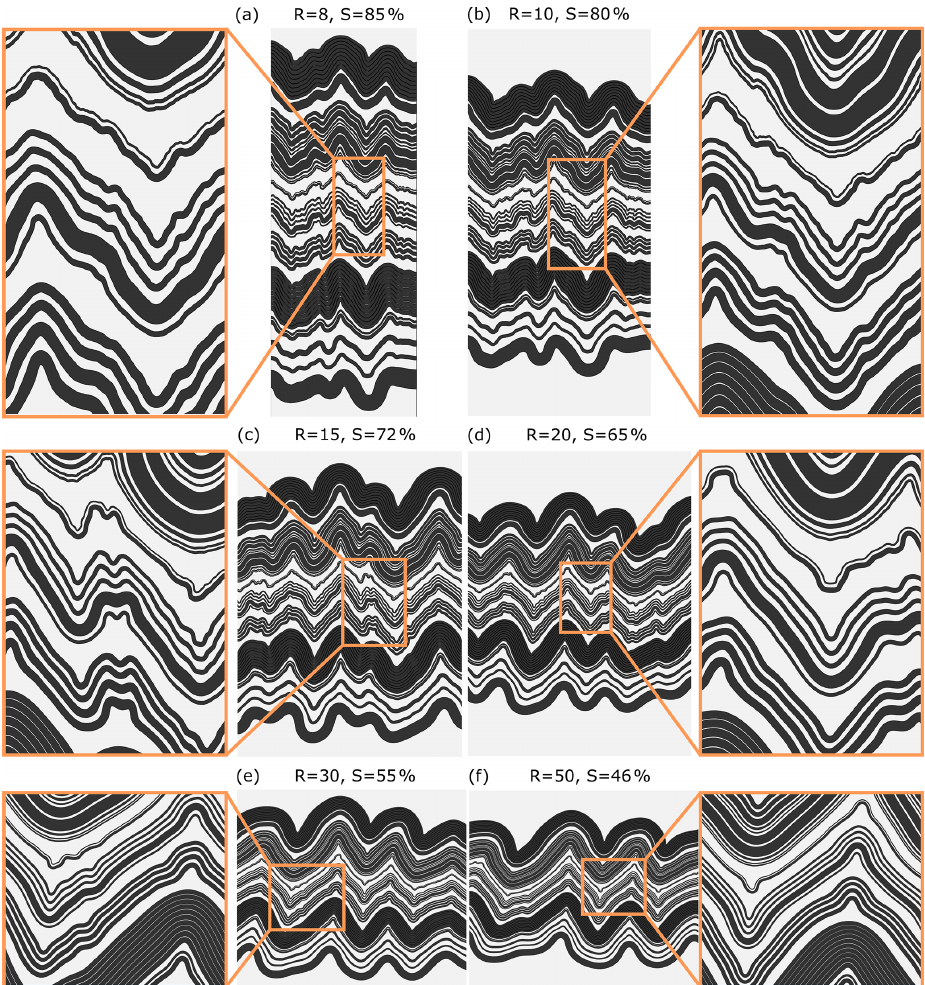
Figure 13. Results of the numerical simulations for different viscosity ratios between dark and white layers ( R ) and shortening ( S ) val- ues: (a) R = 8% and S = 85%, (b) R = 10% and S = 80%, (c) R = 15% and S = 72%, (d) R = 20% and S = 65%, (e) R = 30% and S = 55%, and (f) R = 50% and S = 46%. In the model, the normalised initial amplitude of interface perturbation, A pert /h ref , is set to 0.15, and the thickness of the outer soft layers, H out /h ref , is set to